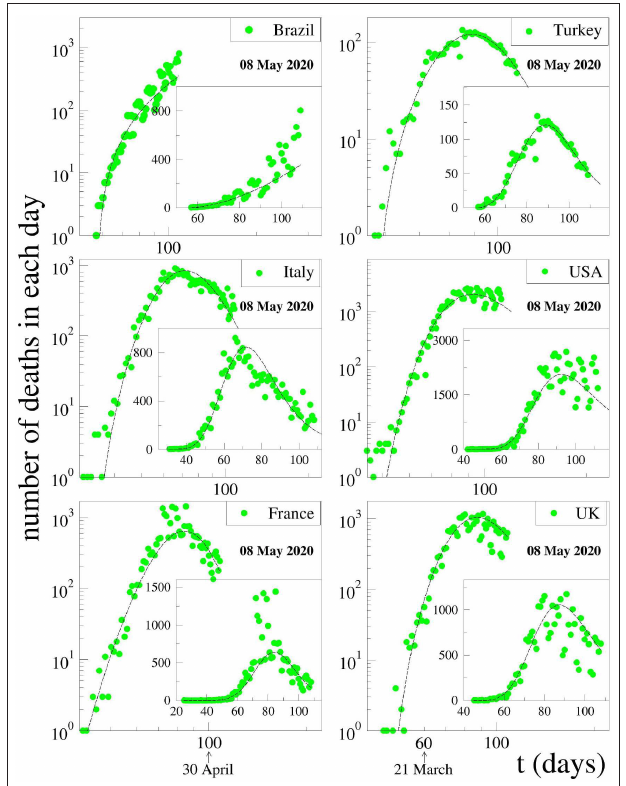
FIGURE 4 | Fits of data on deaths per day for various strongly affected countries around the world with Equation (1). The data are those available at 08 May 2020. The fitting parameters γ and q are fixed at one of the two choices for the values for China, namely ( γ , q ) = (3,1.26). The other fitting parameters, namely ( C death , α death , β death ), have been chosen to better fit the available data for each